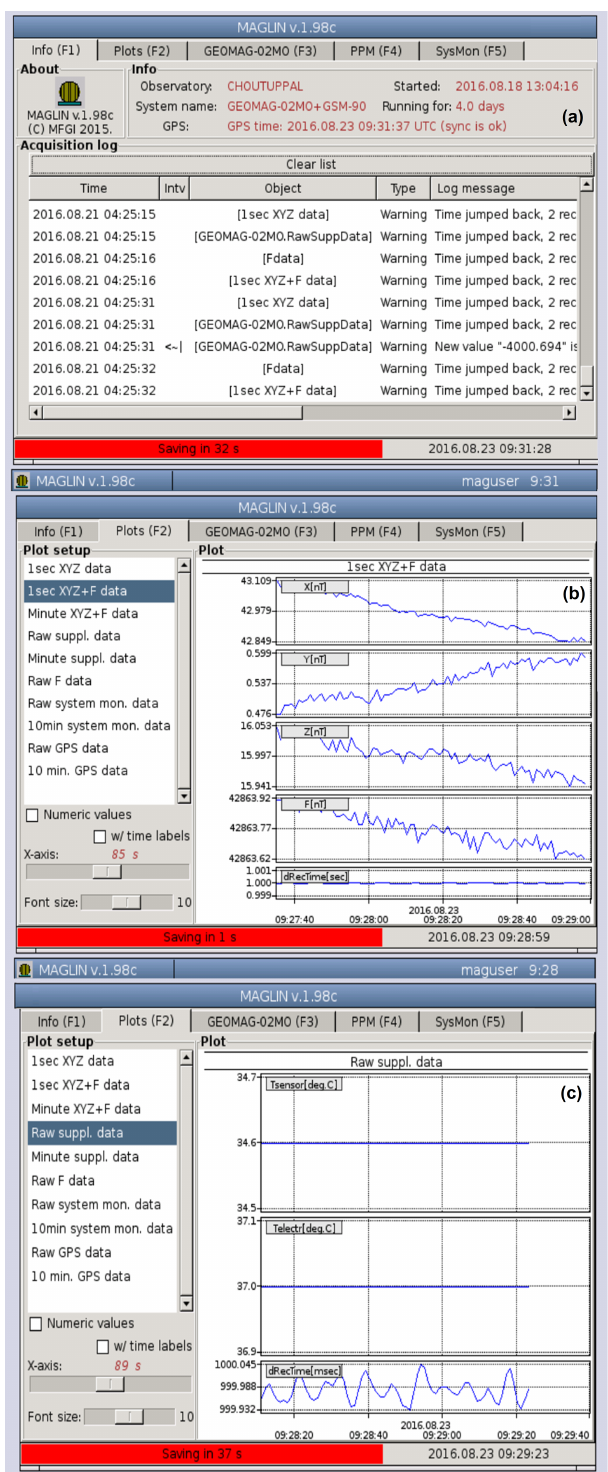
Figure 8. Details of data logging and real-time plotting tools of the Magrec-4B data acquisition